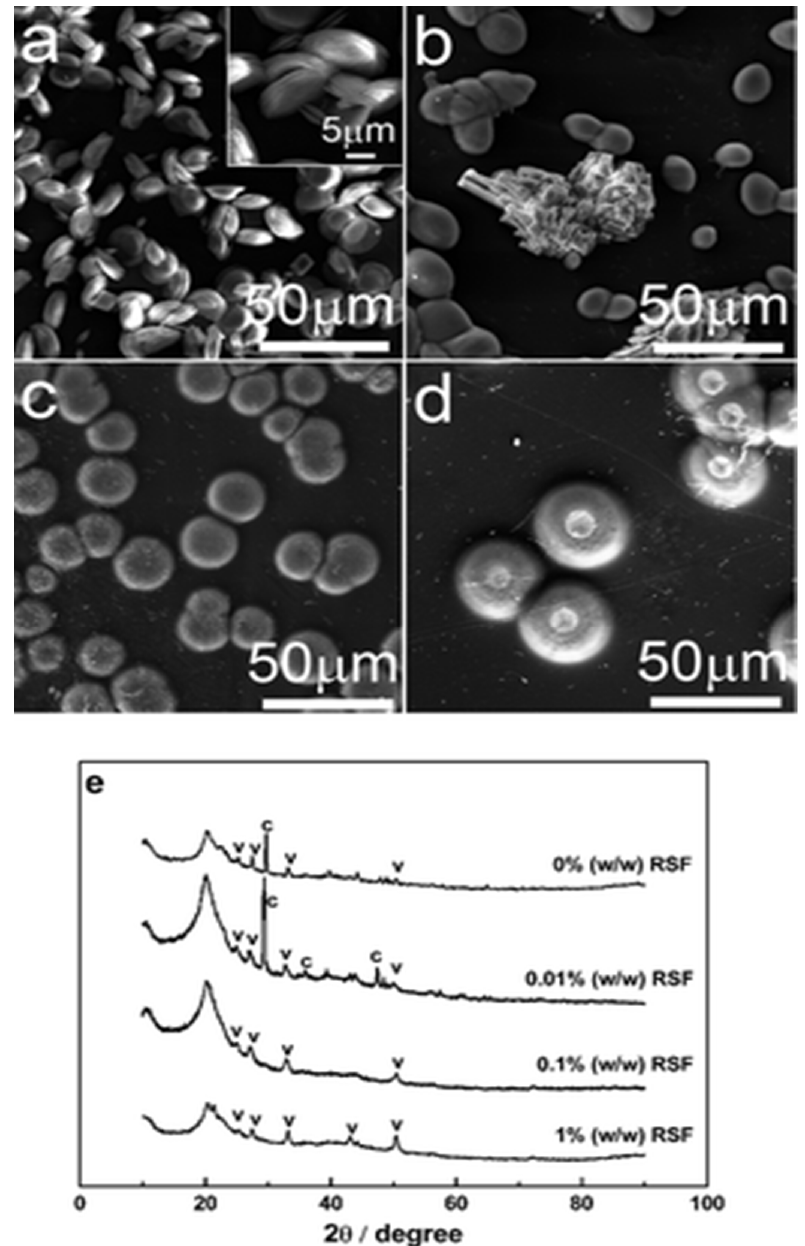
Figure 17. CaCO 3 products grown on chitosan membranes with a range of concentrations of RSF at initial pH 7.9 for 1 day. ( a ) 0% ( w / w ), ( b ) 0.01% ( w / w ), ( c ) 0.1% ( w / w ), ( d ) 1% ( w / w ), and ( e ) XRD patterns of CaCO 3 products above. “c” = calcite; “v” = vaterite. This figure was adapted with permission from [68].